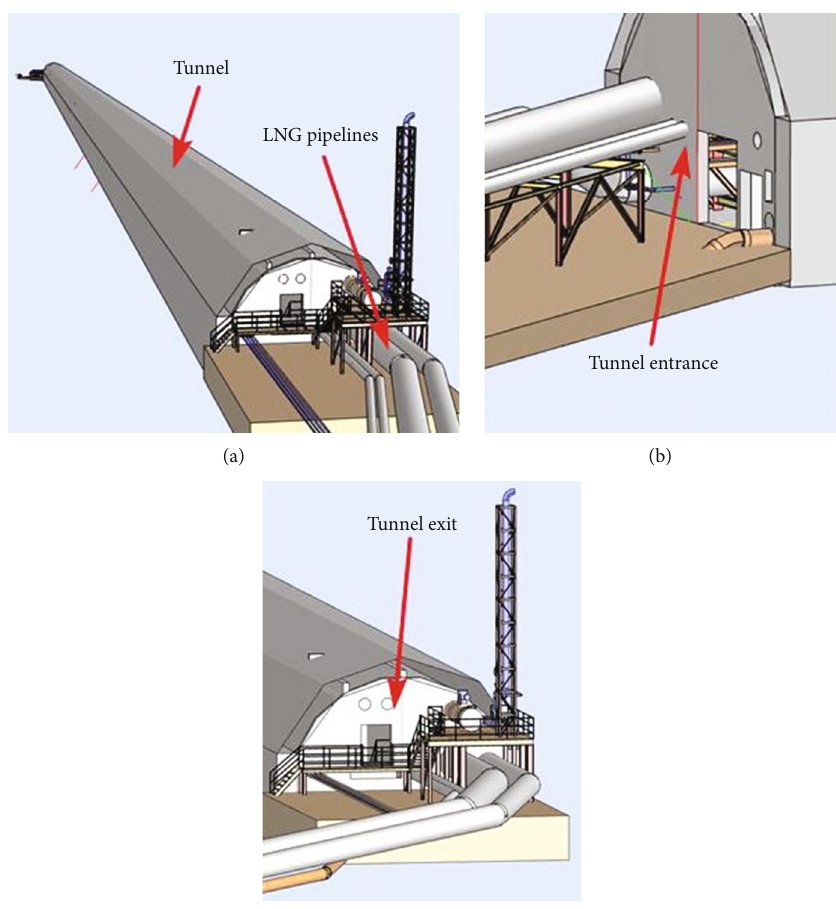
Figure 4: 3D model of Shenzhen tunnel for an LNG pipeline.